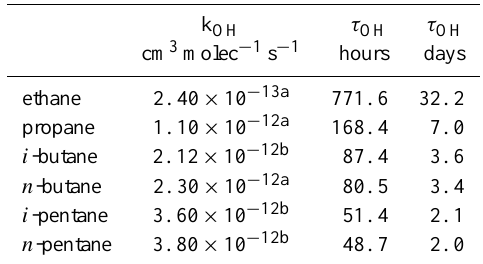
Table 3. Rate coefficients and atmospheric lifetimes with re- spect to OH reactivity for a range of NMHCs where [OH]